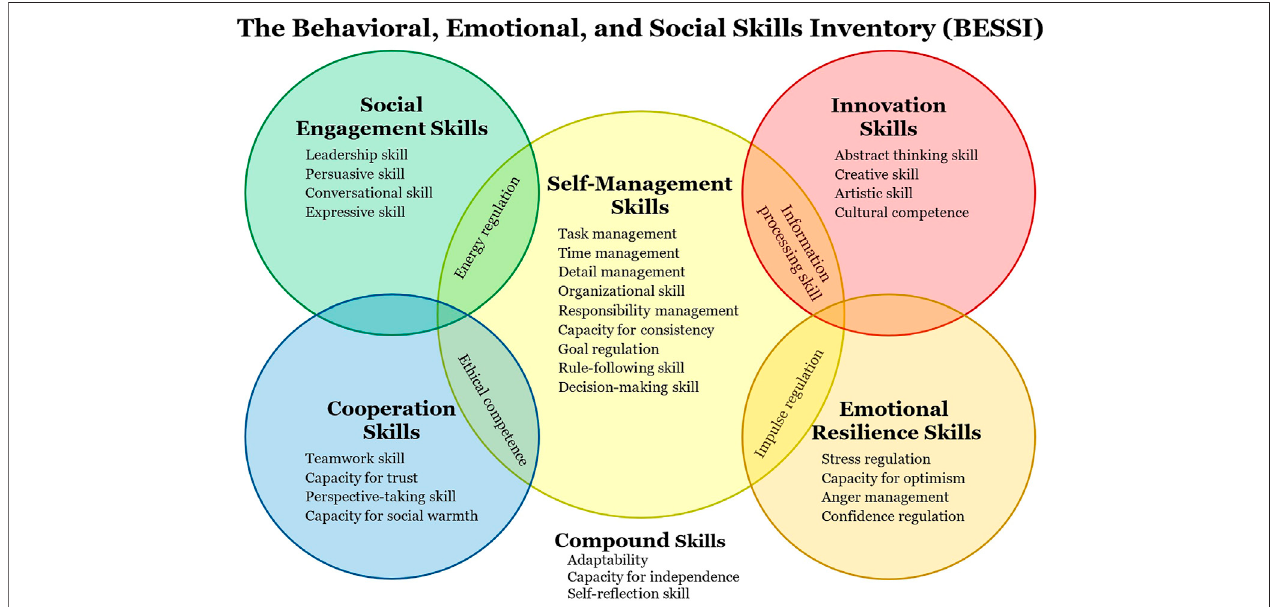
FIGURE 1 | A proposed domain-level taxonomy of SEB